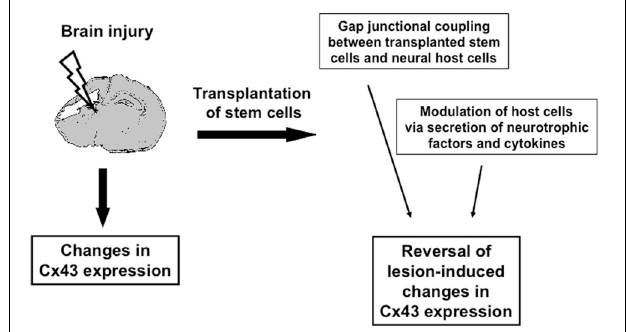
FIGURE 1 | Schematic illustration of how transplanted stem cells might modulate Cx43 changes after brain